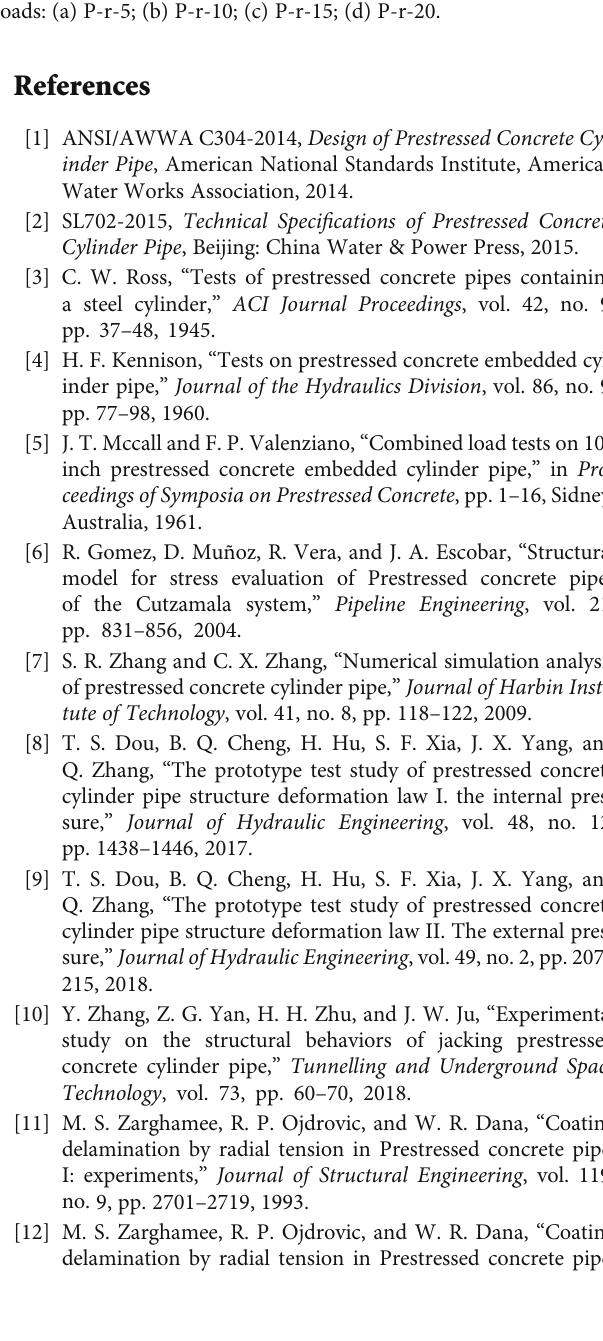
Figure 17: Stress maps of CFRP under combined loads: (a) P-r-5; (b) P-r-10; (c) P-r-15; (d)